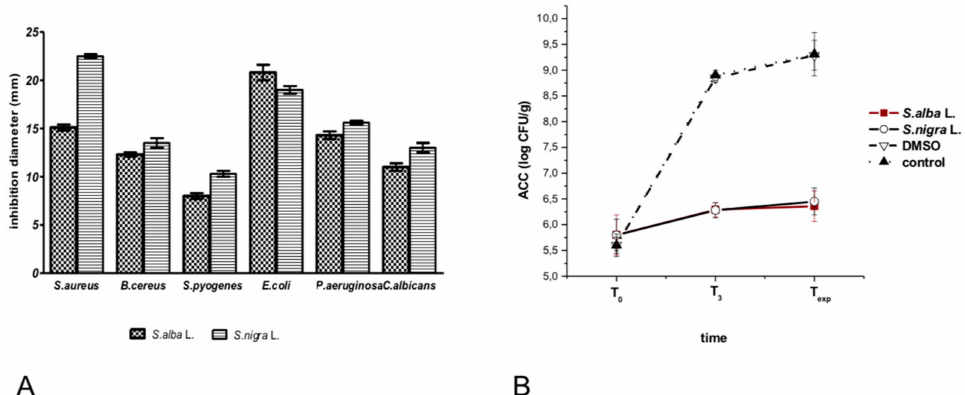
Figure 4. Antimicrobial activity of S. alba and S. nigra seed ethanolic extracts: ( A ) disc diffusion tests on several American Type Culture Collection (ATCC) strains (inhibition zones is expressed in mm); ( B ) bacterial growth trends in fresh-to-eat salad. Aerobic Colony Count (ACC) was measured at different times; T 0 : packaging date; T 3 : day 3; T exp : day